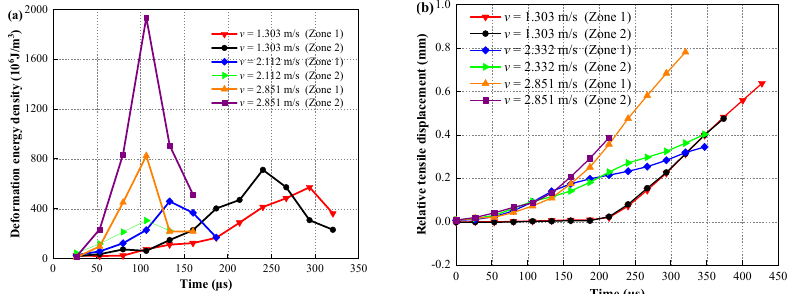
rate. When the time was increased to 200 μ s, the displacement of the two groups of meas ‐ urement points had a difference of about 0.05 mm. The relative tensile displacement in ‐ peak.